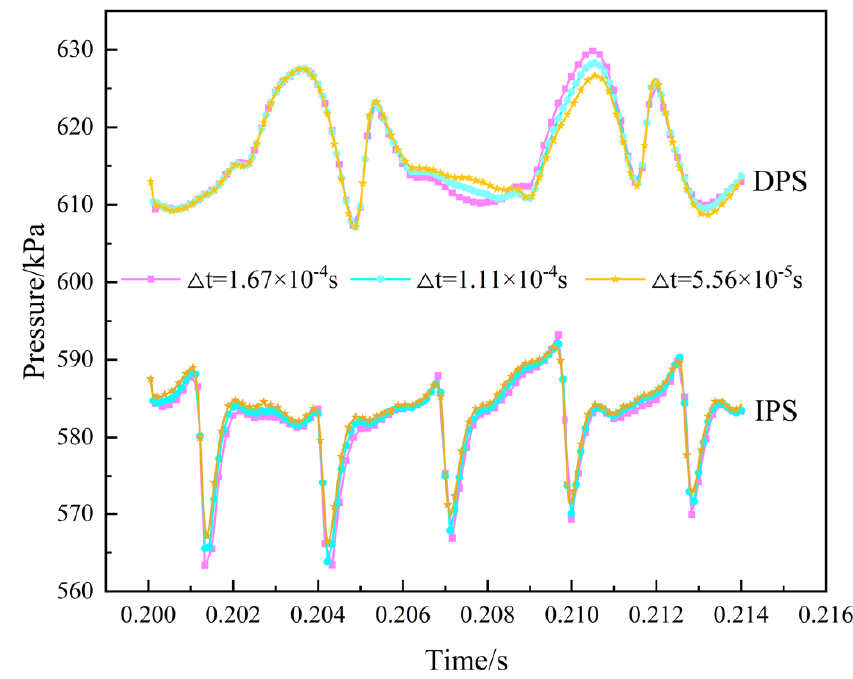
Figure 4. Time step independence verification.